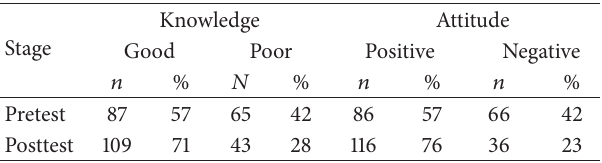
Table 1: Knowledge and attitudes of the staff before and after the tests.